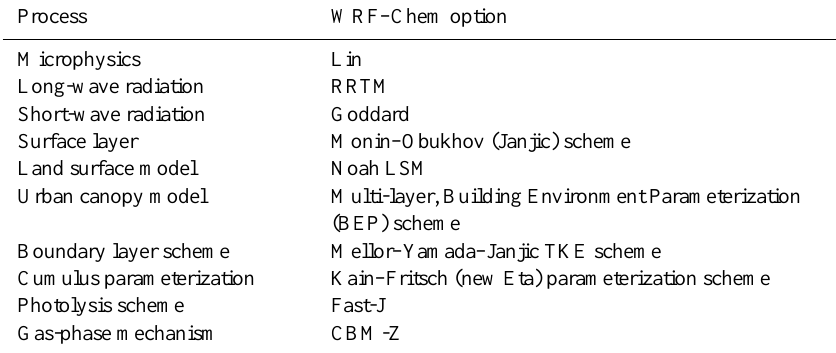
Table 1. WRF–Chem